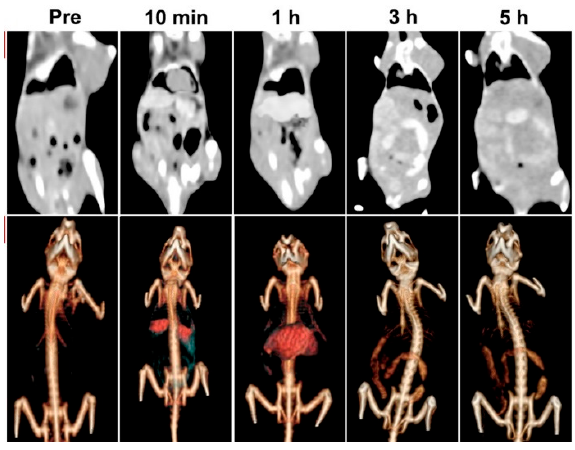
Figure 7. CT images and renderings of CT images of rat after the administration of bismuth modified nanoparticles after different times. Adapted with permission from Bi et al. [96] . Copyright 2018 American Chemical Society.